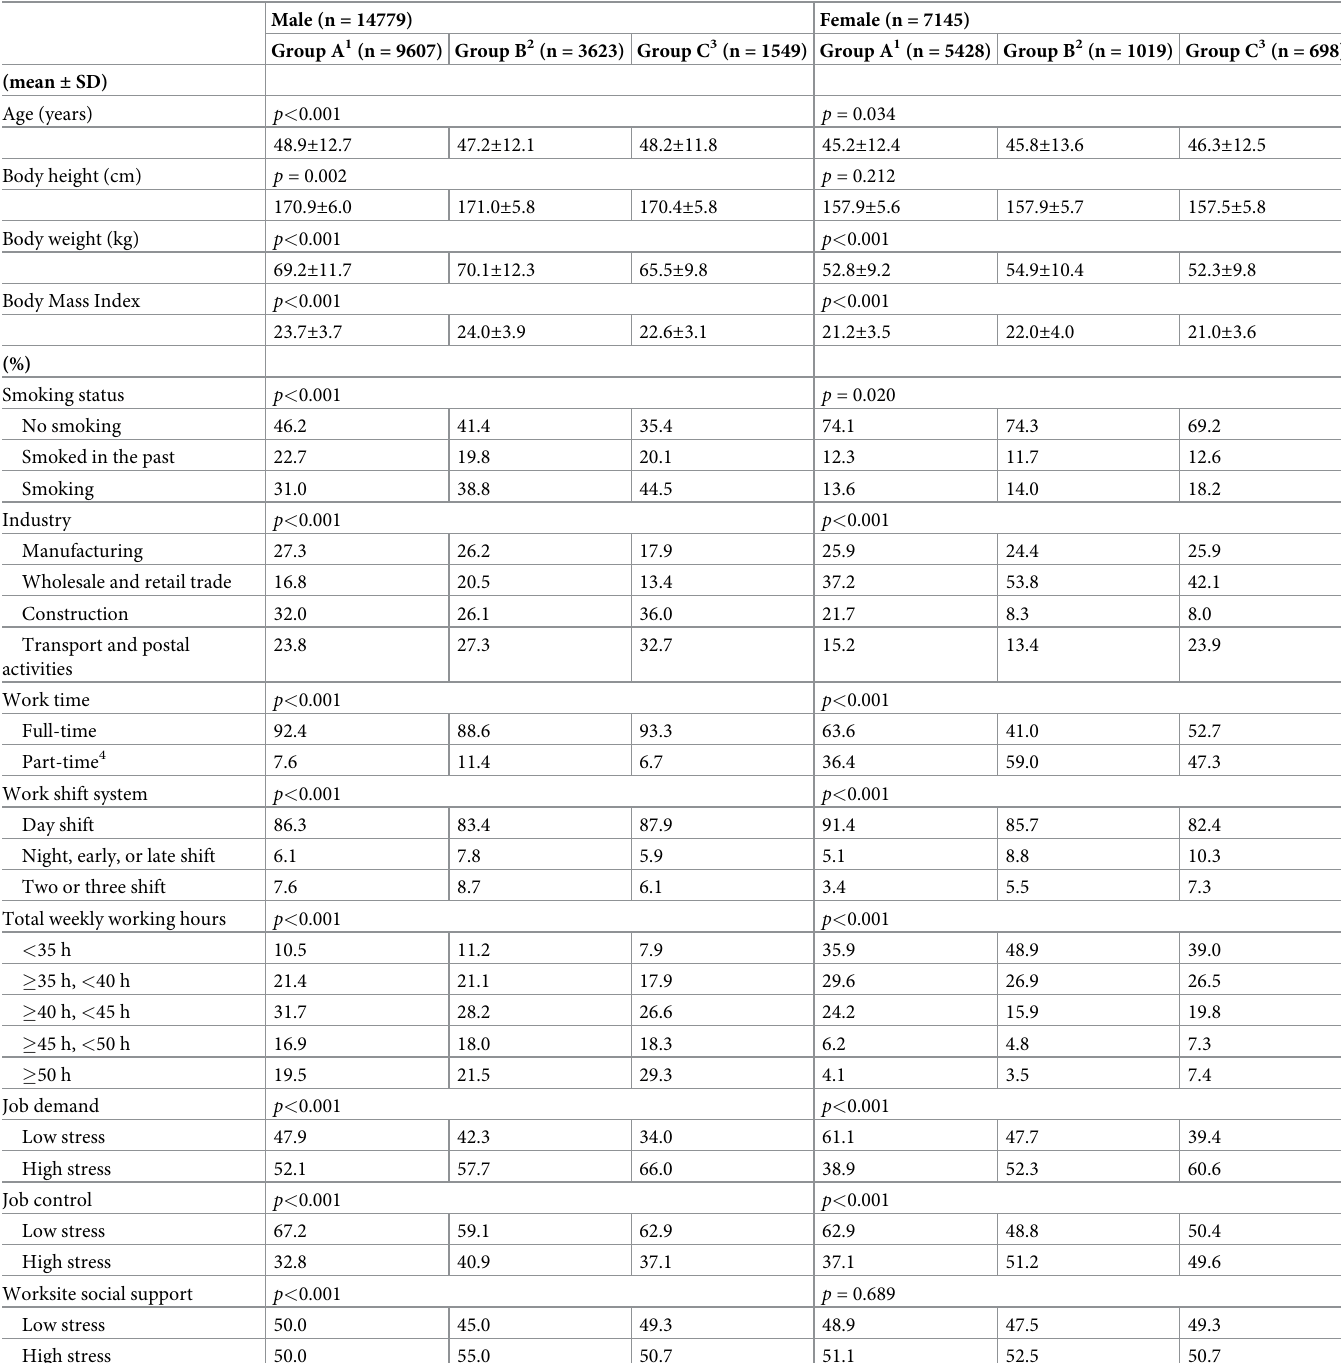
Table 1. Basic characteristics of